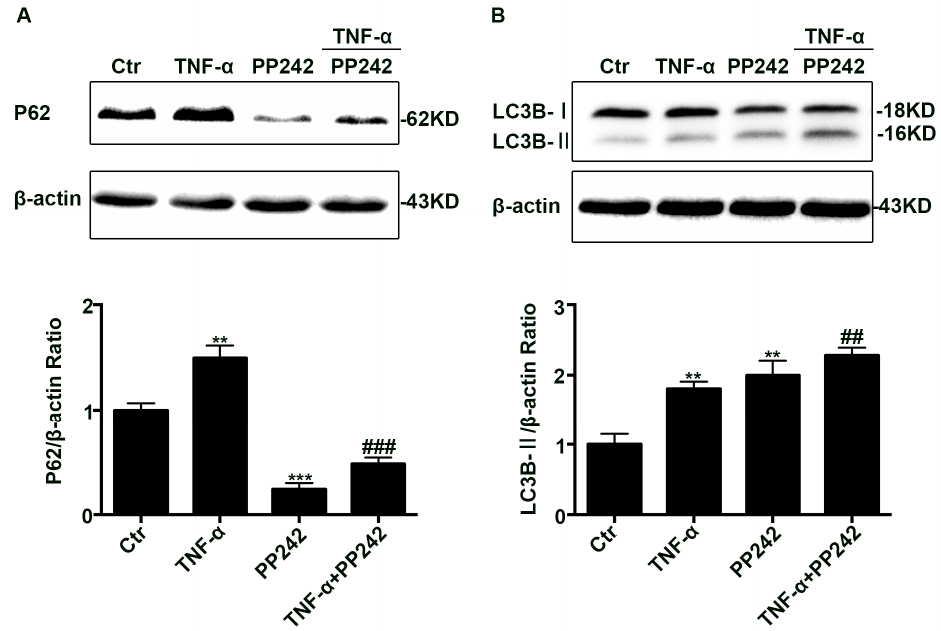
Figure 4. PP242 alleviated the change of autophagy flux caused by TNF- α . ( A , B ) Western blot analysis of P62 and LC3B-II after TNF- α (10 ng/mL, 48 h) and/or PP242 (1 μ m, 24 h) treatment. Data were shown as mean ± SD and replicated three times. ** p < 0.01, *** p < 0.001 versus control group. ## p < 0.01, ### p < 0.001 versus TNF- α group. Ctr, control group.